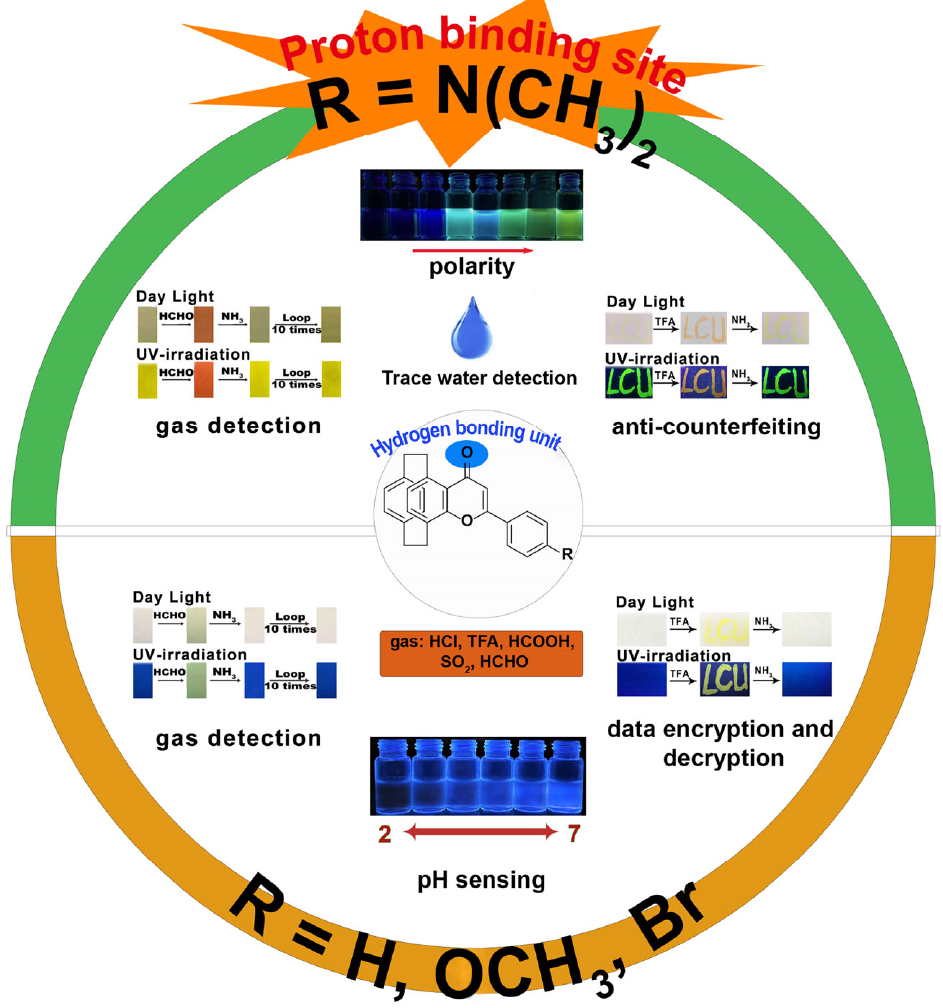
Figure 3. The applications of 11a–d in detecting trace water, pH values, acidic gases, and HCHO. In 2022, our group reported AIE-active PCP-based aurones ( R p )/( S p )-13 (Scheme 4) [29], which were constructed by fusing an aurone moiety with PCP and exhibited aggregation- induced CPL (AICPL) properties. Interestingly, ( R p )/( S p )-13 were prepared by a convenient one-step reaction of ( R p )/( S p )-5-acetyl-4-hydroxy[2.2]paracyclophane with p-nitrobenzaldehyde. This is a special reaction for the preparation of ( R p )/( S p )-13 only, which may be due to the electron-donating conjugation effect of the PCP group and the electron-withdrawing effect of the nitro group. We also compared the fluorescence properties of ( R p )/( S p )-13 with the phenyl-based aurone (Figure 4) and found that ( R p )/( S p )-13 exhibited stronger ICT character and typical AIE behavior. Moreover, ( R p )/( S p )-13 showed moderate fluorescence with yellow color under UV-irradiation compared with the weak fluorescence and nattier blue color of the phenyl-based aurone. We also compared the crystal structures and the